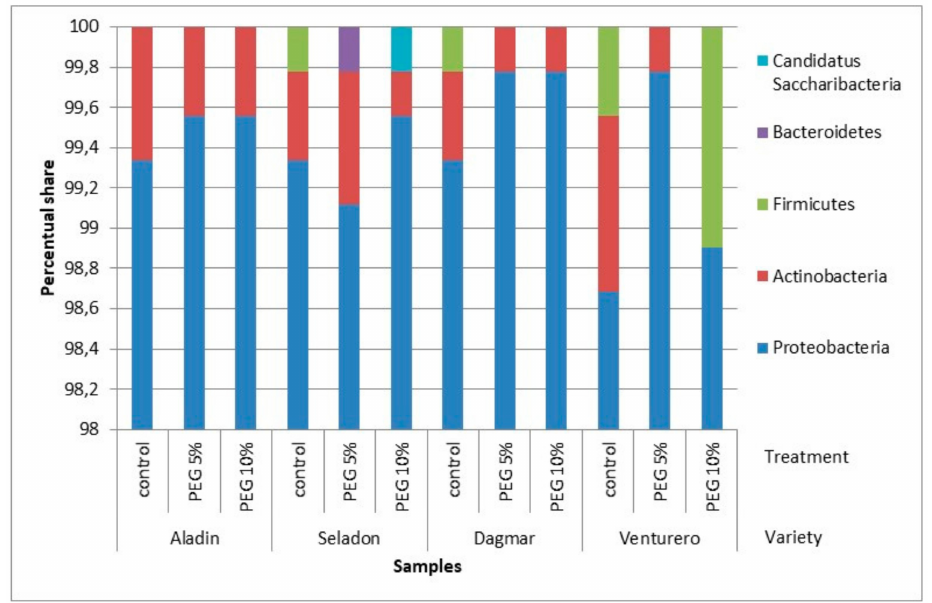
Figure 4. Distribution of the OTUs. Relative sequence abundance of bacterial phylla associated with the in vitro wheat varieties from pooled samples. Relative sequence abundance was calculated as the proportion of sequences belonging to a particular class of all 16S rRNA sequences